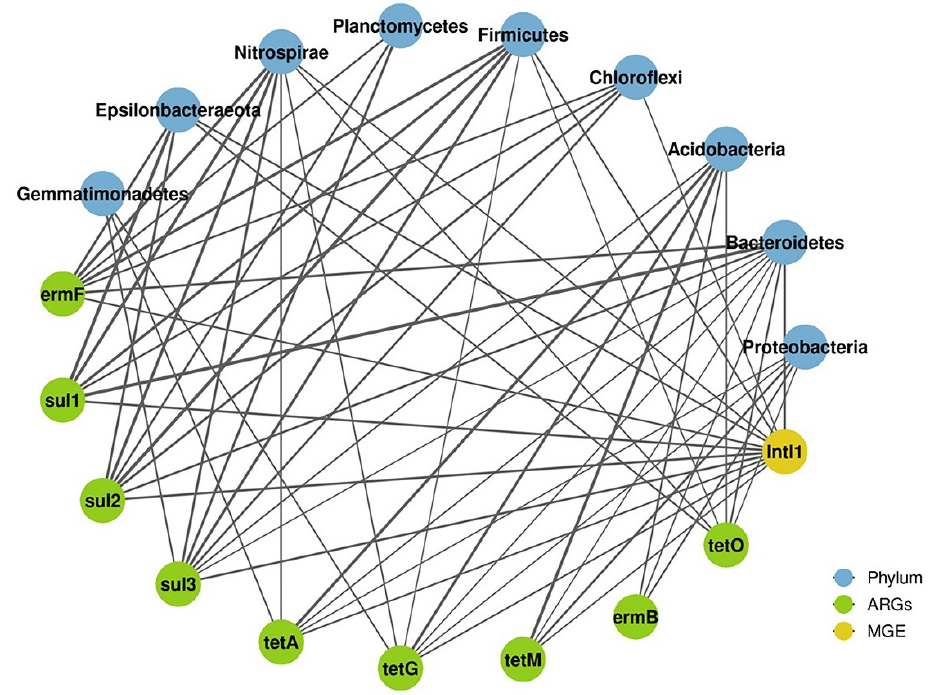
Figure 4. The correlation network represents the symbiotic relationship between ARGs and bacteria communities. Nodes with different colors represent different kinds of ARGs or bacteria.